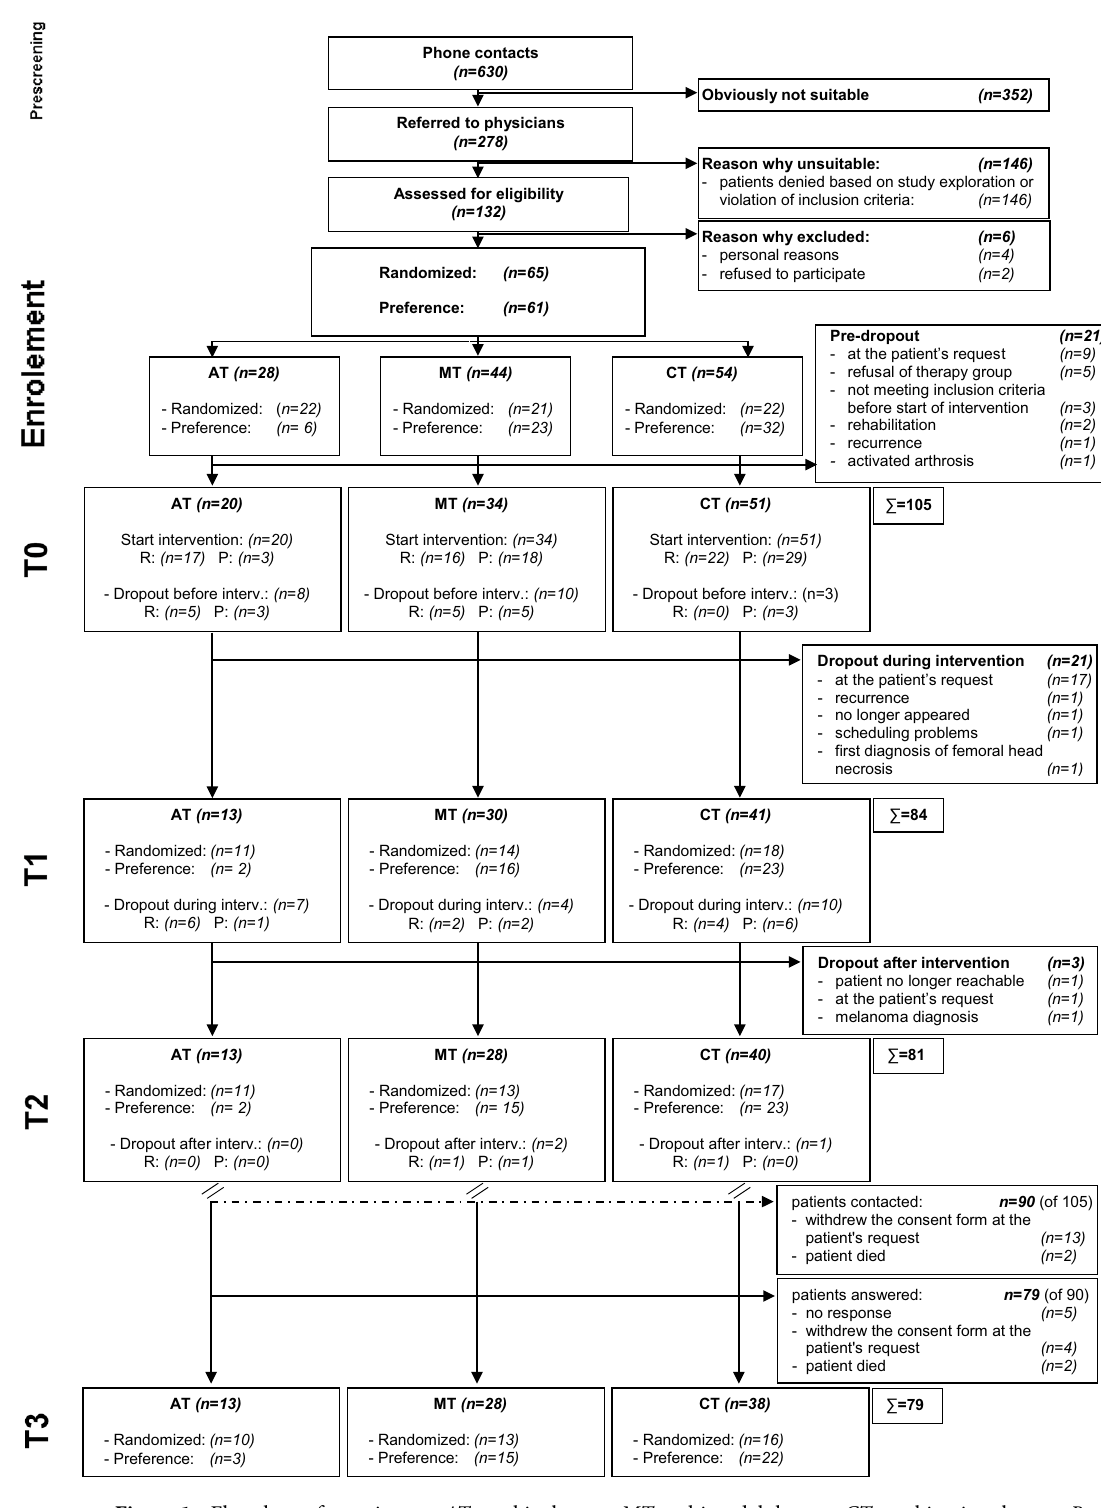
Figure 1. Flowchart of recruitment. AT aerobic therapy, MT multimodal therapy, CT combination therapy, R randomized, P preference, T0: baseline, T1: after 10 weeks of intervention, T2: after 6 months, T3: after 4